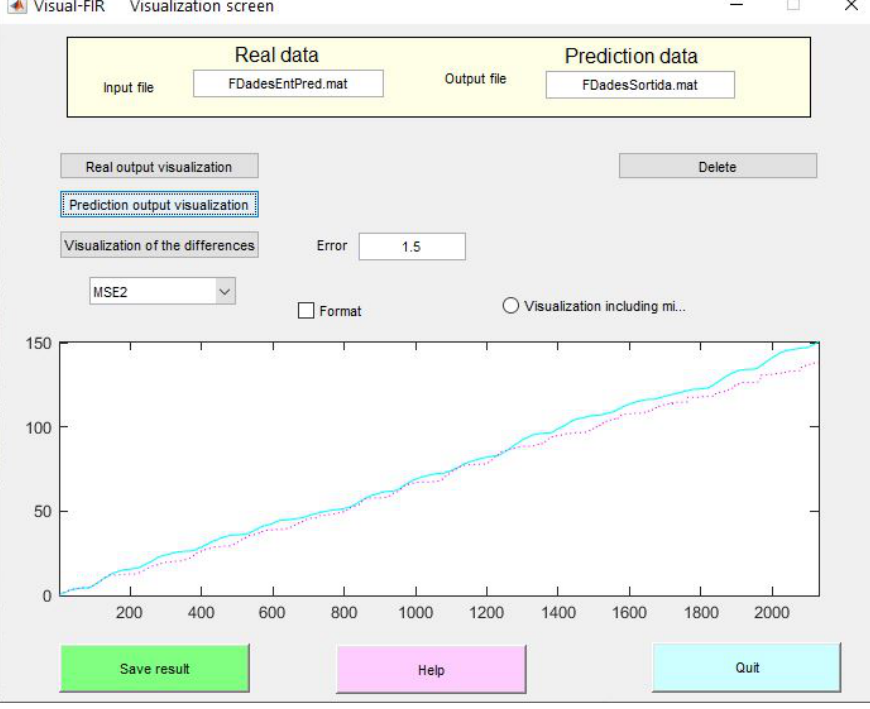
Figure 8. Visual-FIR visualization screen with real (blue line) and predicted (red dashed line)